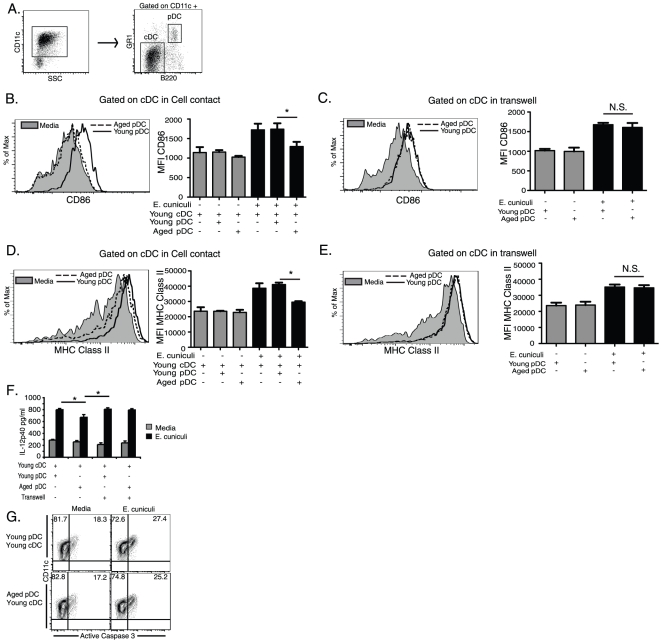
pDC from aged mice suppress cDC maturation via cell contact.To test cell contact dependence of aged pDC effect, 1.25×105 sort purified naïve splenic young (8 week) mouse cDC were co-cultured with or without 1.0×104 naïve young or aged (12 month) mouse splenic pDC or separated by a permeable membrane in a transwell culture system then stimulated 1∶1 with irradiated E. cuniculi spores for 12 hours. After live/dead staining and exclusion of cell clusters as shown in (A) cDC (CD11c hi B220-GR1−) were gated and analyzed for (B and C) CD86 and (D and E) MHC Class II in cell contact (B and D) or in transwell (C and E) cultures. Representative histograms show expression of CD86 (B and C) and MHC Class II (D and E) by cDC co-cultured in cell contact (B and D) or separated by a transwell (C and E) from aged pDC (dashed line) or young pDC (solid line) before (gray filled histogram) or after stimulation with E.cuniculi spores. Bar graphs show mean ± SD MFIs of CD86 (B and C) and MHC Class II (D and E) on cDC from cell contact (B and D) or transwell (C and E) cultures conditions. Bar graphs for CD86 (B) and MHC Class II (D) also included cDC cultured alone with and without stimulation. Data presented in bar graphs is from 2 independently repeated experiments. * denotes significance measured by 1 way ANOVA and Bonferroni's multiple comparison test with p<0.05. (F) Bar graph shows IL-12p40 production from supernatants of pDC and cDC co cultures (* denotes significance with p<0.05 by Student's t test). Separately, to measure level of cDC apoptosis, co-cultured cDC were gated as in A and assayed for active caspase-3 staining by flow cytometry. (G) Contour plots show percent CD11c+ active caspase-3+positive cells. This experiment was repeated independently twice in triplicate with similar results. Data presented is from 1 of those experiments.